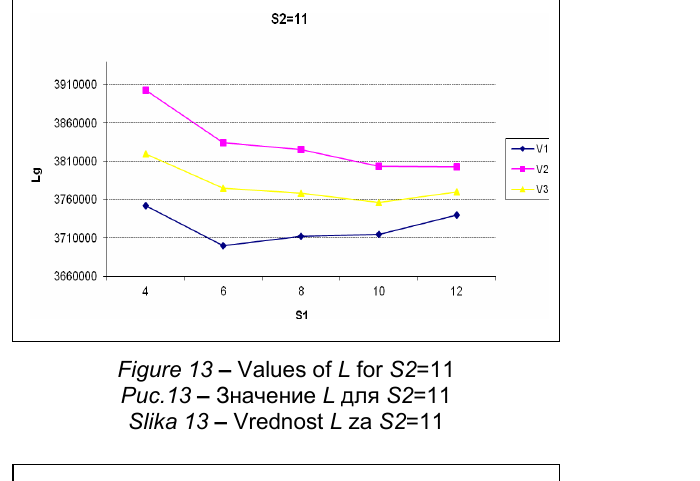
Figure 13 – Values of L for S2 =11 Рис .13 – Значение L для S2 =11 Slika 13 – Vrednost L za S2 =11